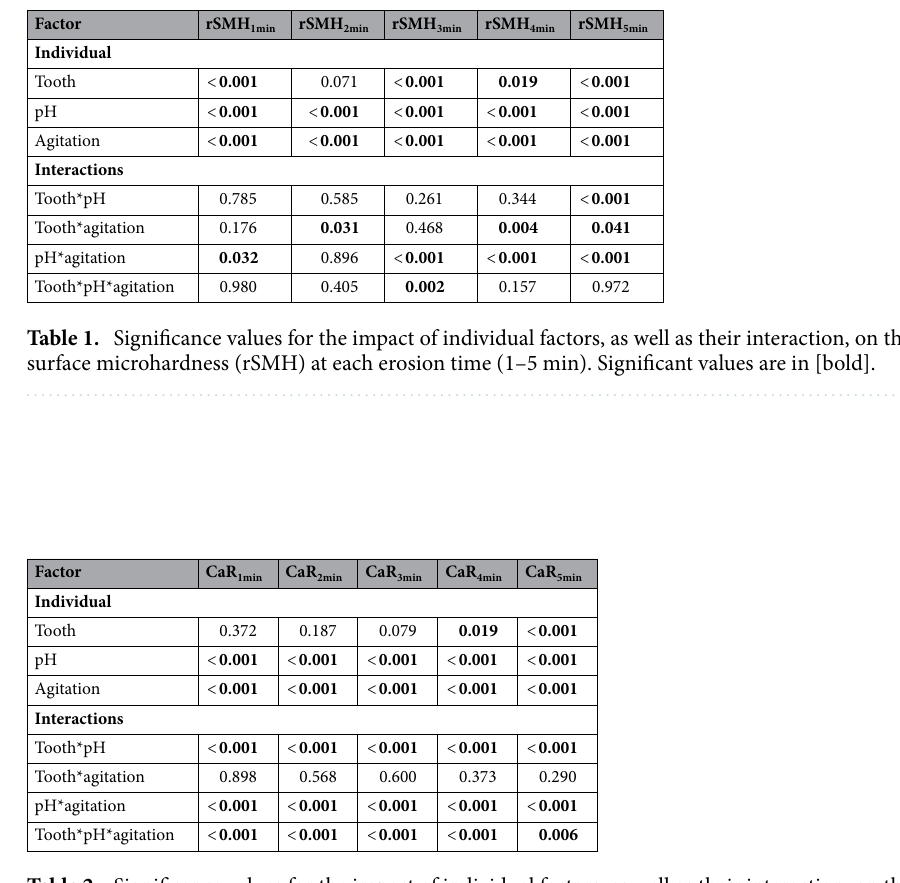
Table 2. Significance values for the impact of individual factors, as well as their interaction, on the calcium release (CaR) at each erosion time (1–5 min). Significant values are in [bold].